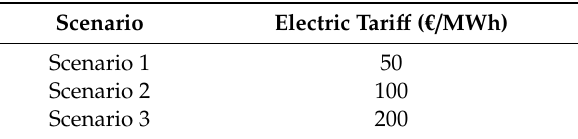
Table 2. Electric tari ff s considered.